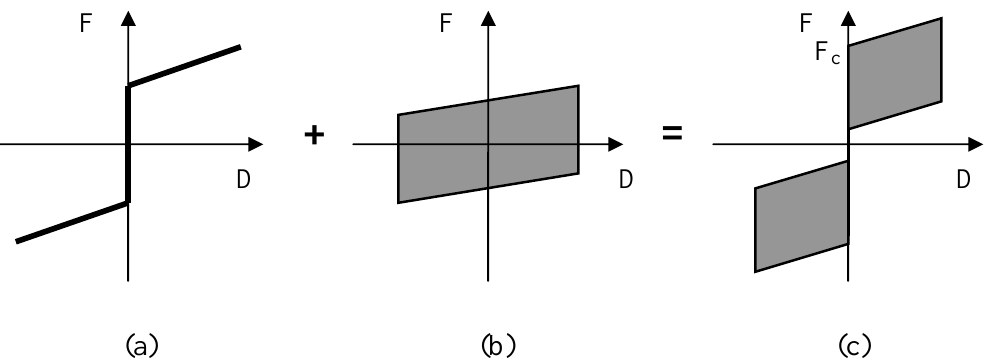
Figure 2 . The realization of the damping device: (a) Spring – recentering element; (b) SMA wire – energy dissipation element; (c) Damper – complete functional